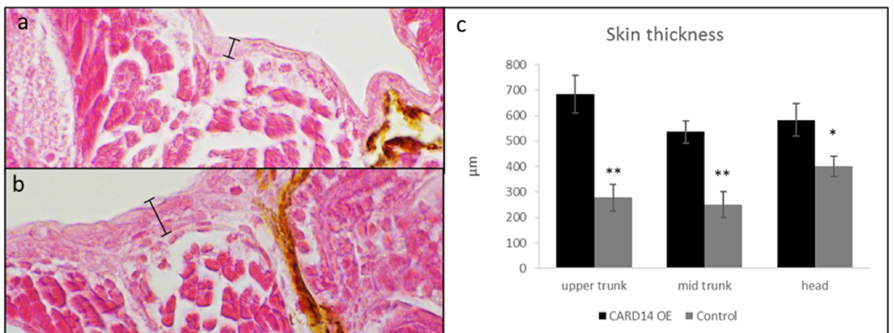
Figure 3. Histopathology at 3 dpf. H&E staining × 40 magnification. Skin of control larvae ( a ) injected with zfcard14- RNA containing a stop codon display a thinner epidermis than larvae injected with zfcard14- RNA ( b ). Graph ( c ) shows average of 6 measurements at 3 different anatomical sites: head at superior edge of eyes, superior and mid trunk (two-sided t -test; * p < 0.05, ** p < 0.01).